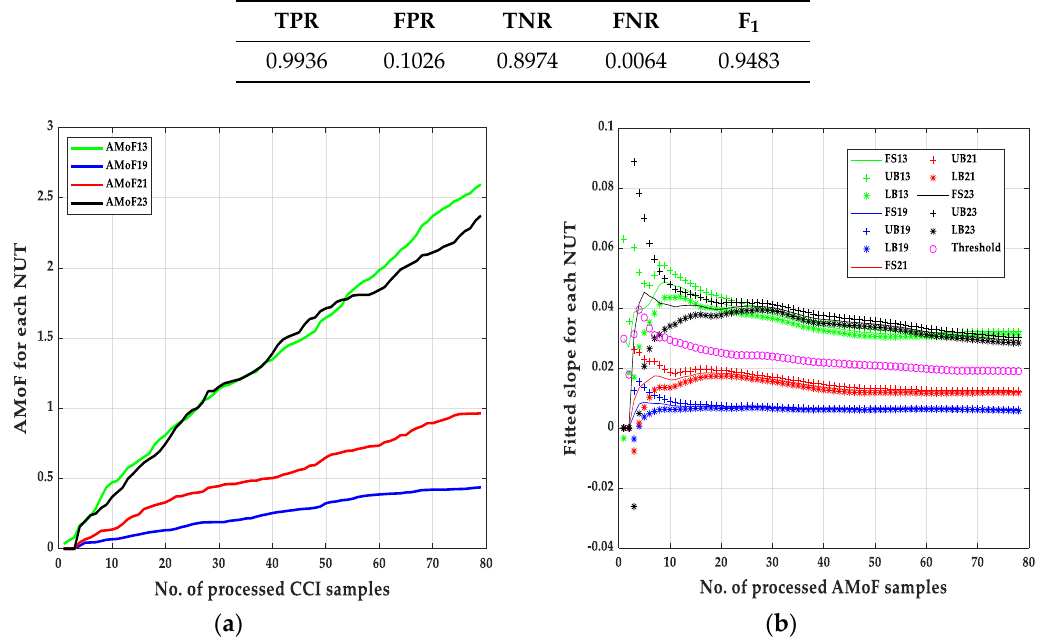
Figure 8. The AMoF and the fitted slope for different nodes for scenario NS1P3: ( a ) The AMoF for different NUT; ( b ) the fitted slope for NS1P3_BH_RWP 25/5. Table 8. Performance characterization for NS1P3_BH_RWP 25/5.